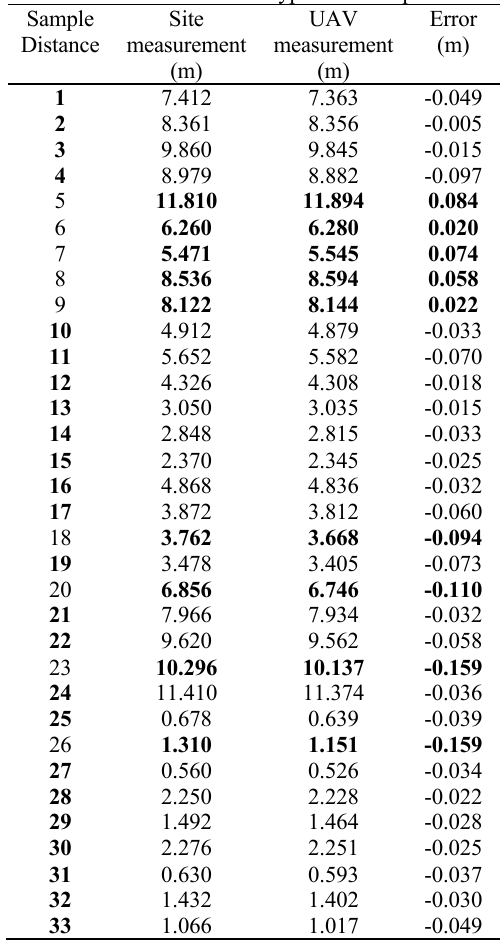
Figure 12 shows the simulation of the accident scene by used virtual crash demo software. The simulation showed the prediction of vehicle collisions that were reconstructed from the data obtained on the